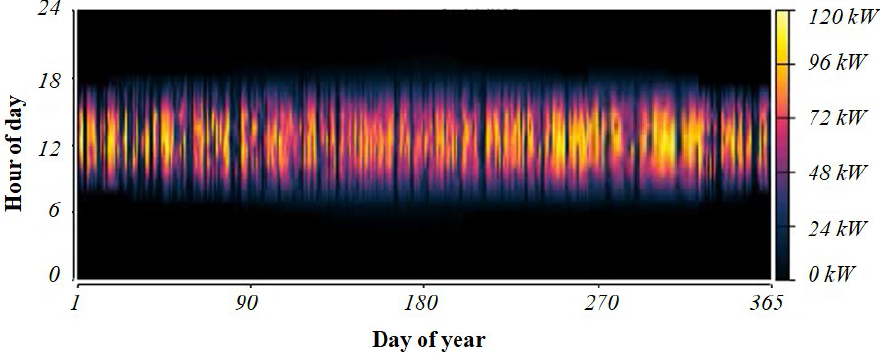
Figure 13. Component-wise cost summary for PV-Wind-BSS-DG configuration.